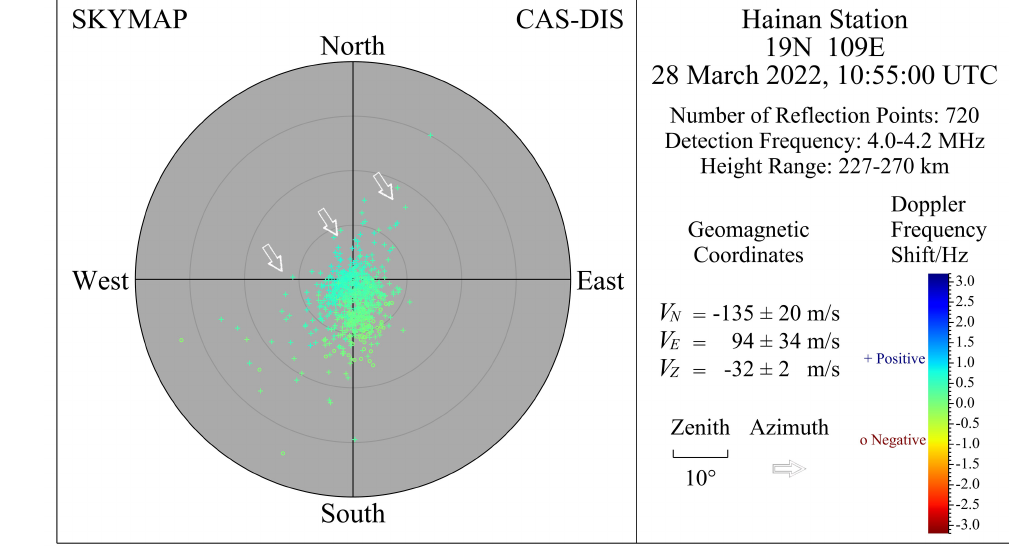
Figure 2. Schematic diagram of the drift measurement